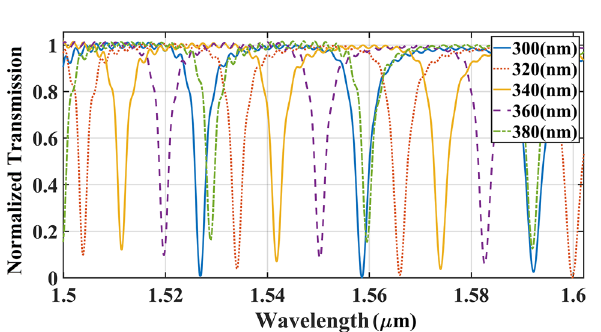
Figure 6. Effect of the total middle and inner rib widths of double-slot ring resonator waveguide on the light transmission spectrum of ICCRR system. Results simulated based on the fixed parameters of Lc = 0 µ m, gap = 180 nm , and WSi_out = 190 nm